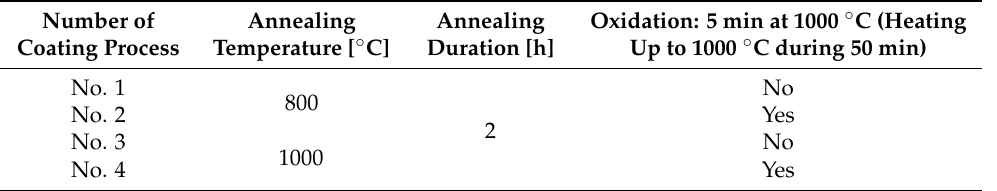
Table 1. Technological parameters of the coating